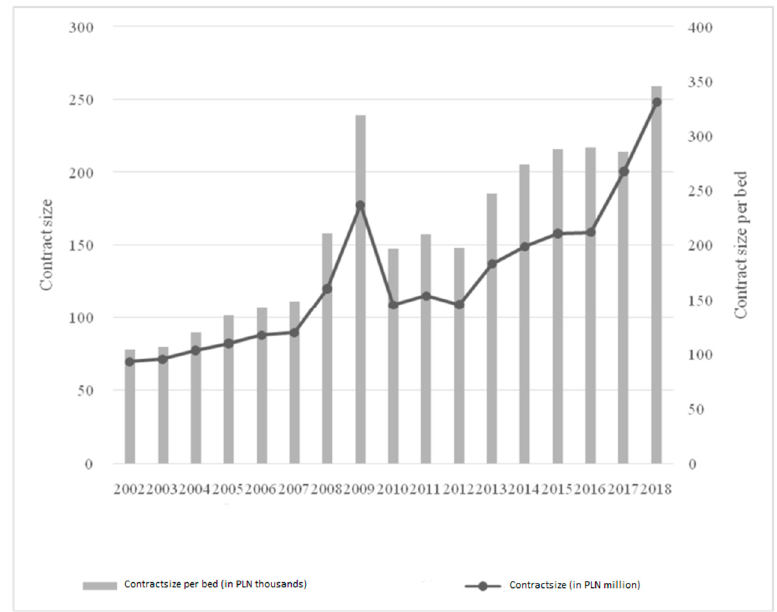
Figure 5. Contract of the analyzed hospital and the amount per hospital bed in the analyzed health care institution.